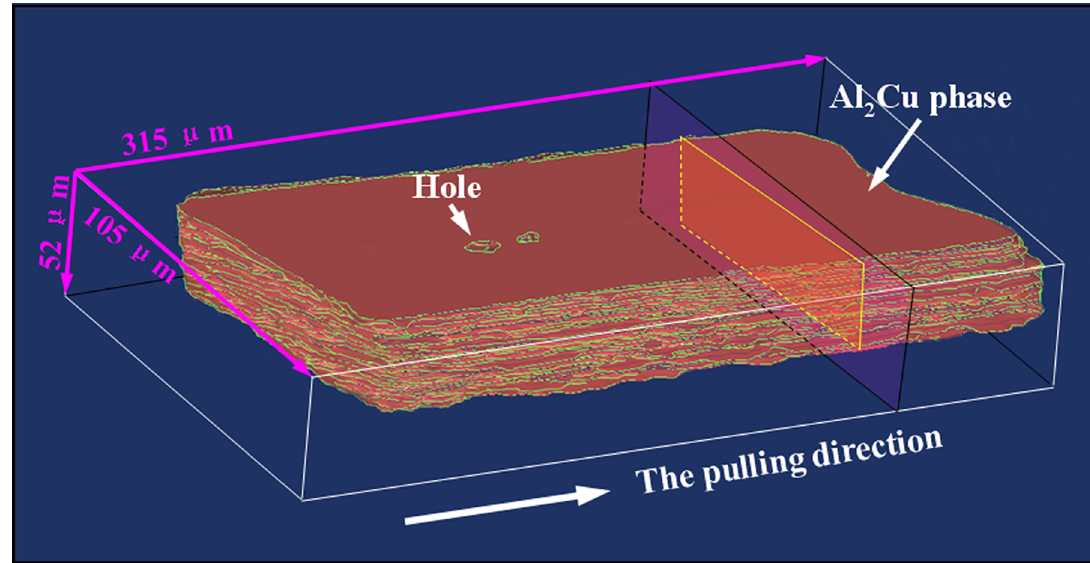
Cu phases crystal in 0.45 mm sample during directional 2